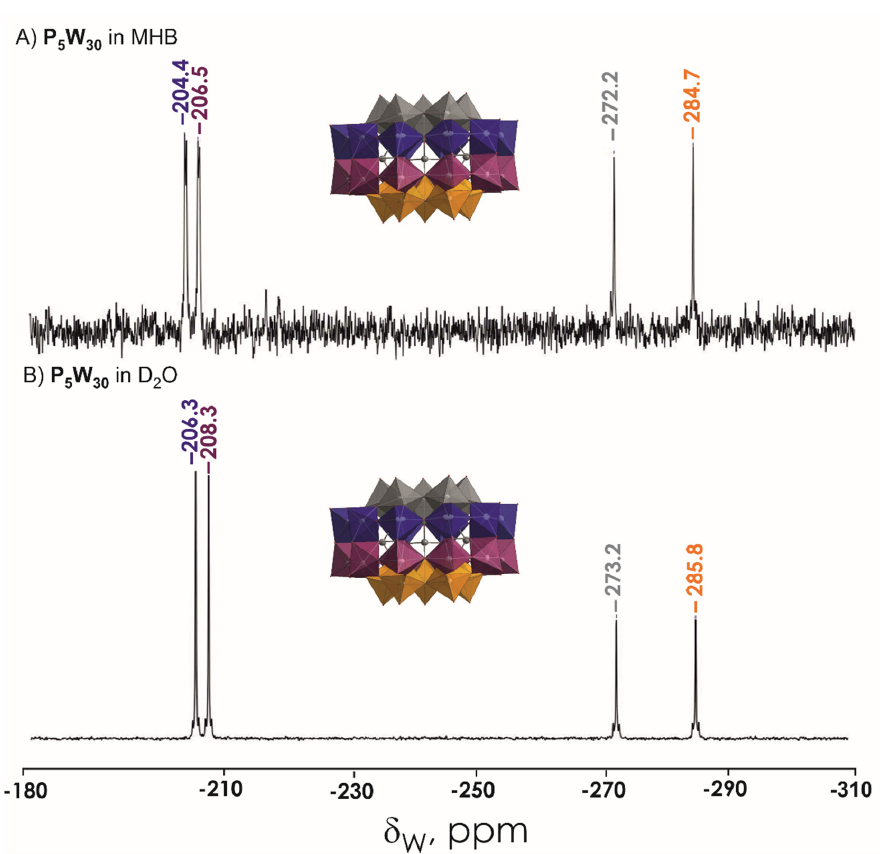
Figure 4. 183 W NMR spectra of 20 mM (NH 4 ) 14 [NaP V5 W VI30 O 110 ] P 5 W 30 solution in ( A ) MHB and ( B ) D 2 O. The signals correspond to four types of W ions in P 5 W 30 shown in different colors. Color code: {WO 6 }, grey, blue, plum, orange; P, grey; O, red.